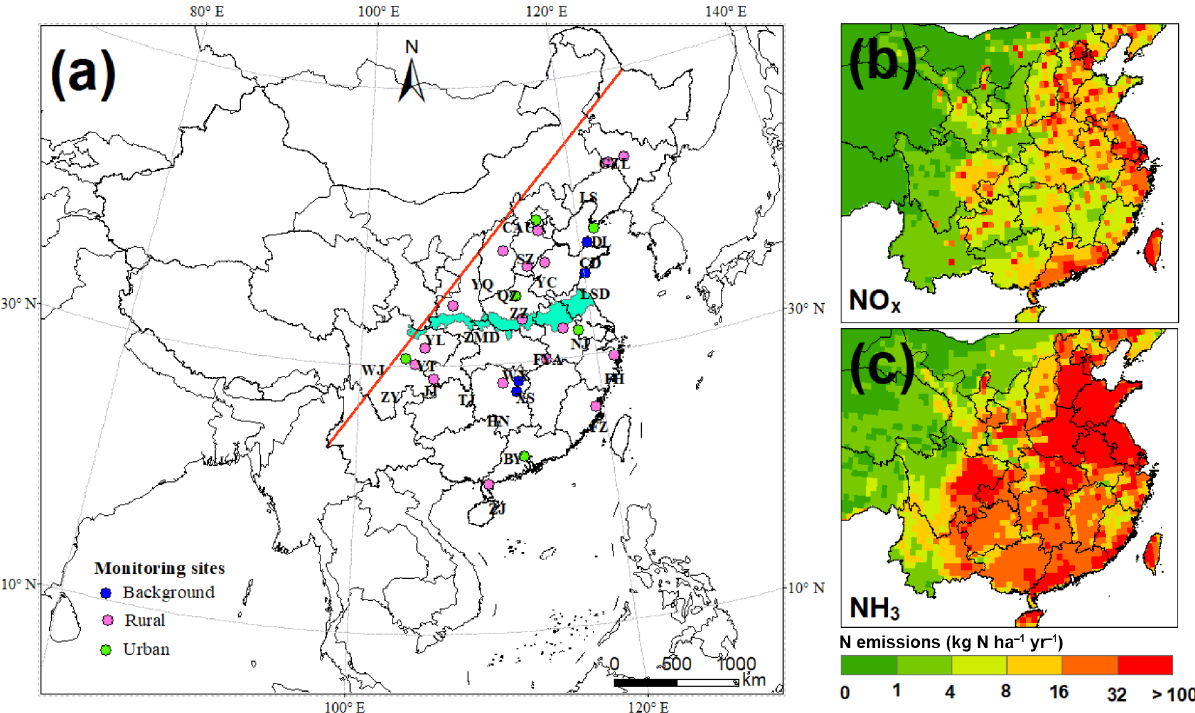
Figure 1. Spatial distributions of the 27 monitoring sites (a) , NO x emissions (b) , and NH 3 emissions (c) in eastern China (NH 3 and NO x emission data were for the year 2010 and obtained from Liu et al., 2017b). The blue and red lines refer to the Qinling–Huaihe line, and Hu line